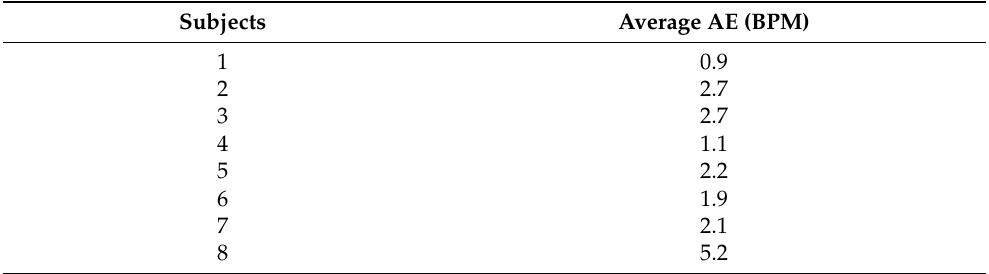
Table 2. The average AE between the reference and estimated RRs for each subject of dataset